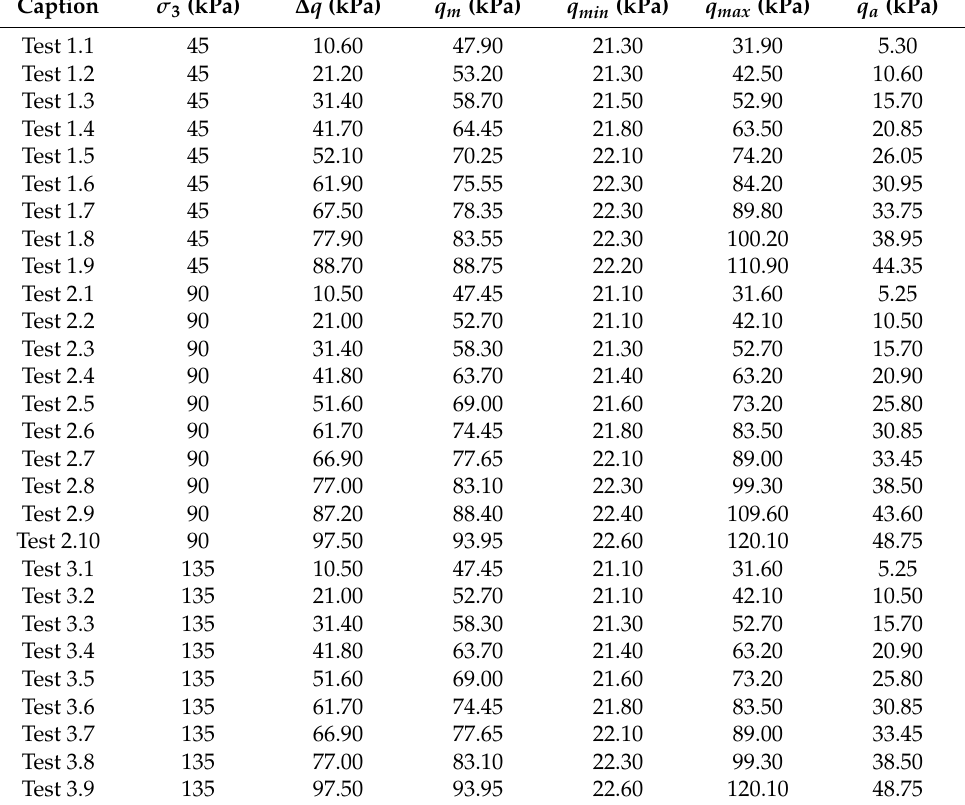
Table 2. The stress parameters of cyclic triaxial test experiment for the tested sandy